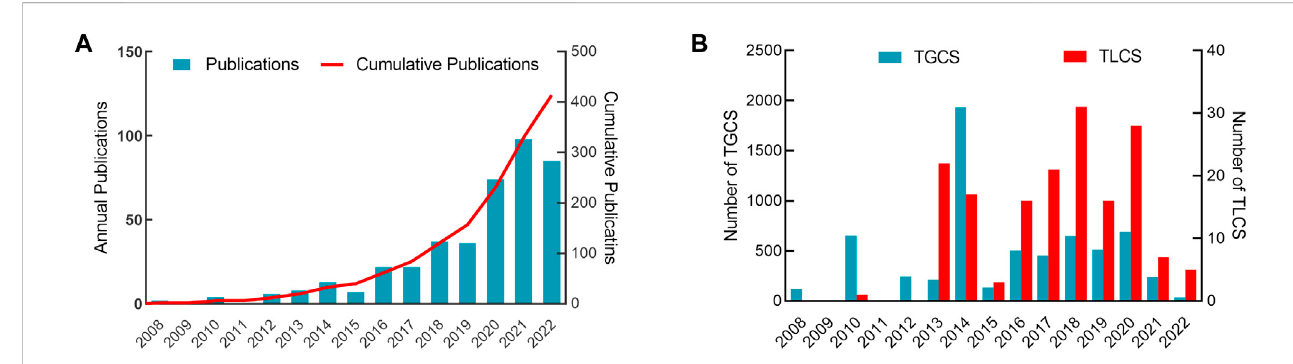
FIGURE 2 OveralldistributionofpublicationoutputsandcitationsonnetworkpharmacologyinNDs. (A) Numberandtrendsofannualandcumulativepublications. (B) Annual number of TLCS and